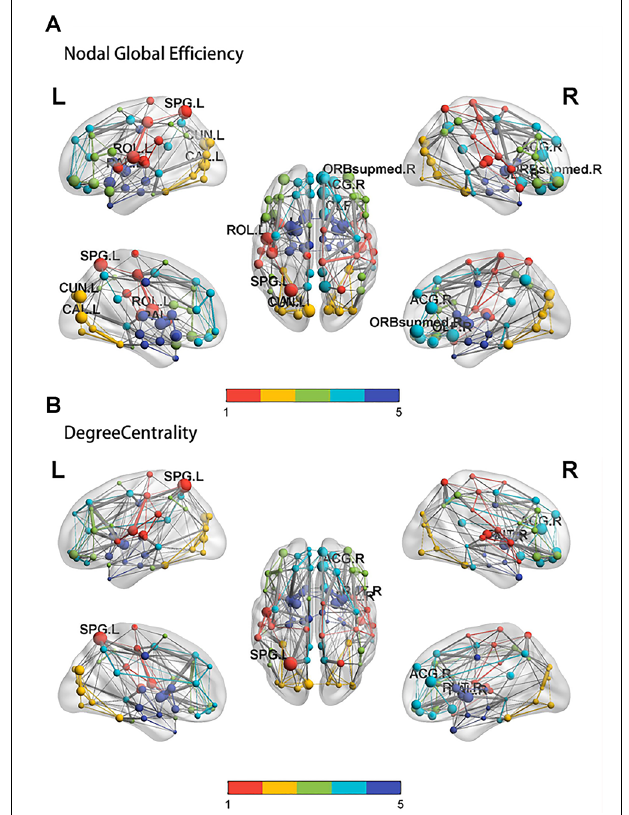
FIGURE 3 | The results of the nodal global efficiency and DC. Compared with controls, the result of the nodal global efficiency (A) and DC (B) in the PSD group. SPG: superior parietal lobule, ACG: anterior cingulated gyrus, ORB supmed: Superior frontal gyrus, medial orbital, CAL: calcarine,